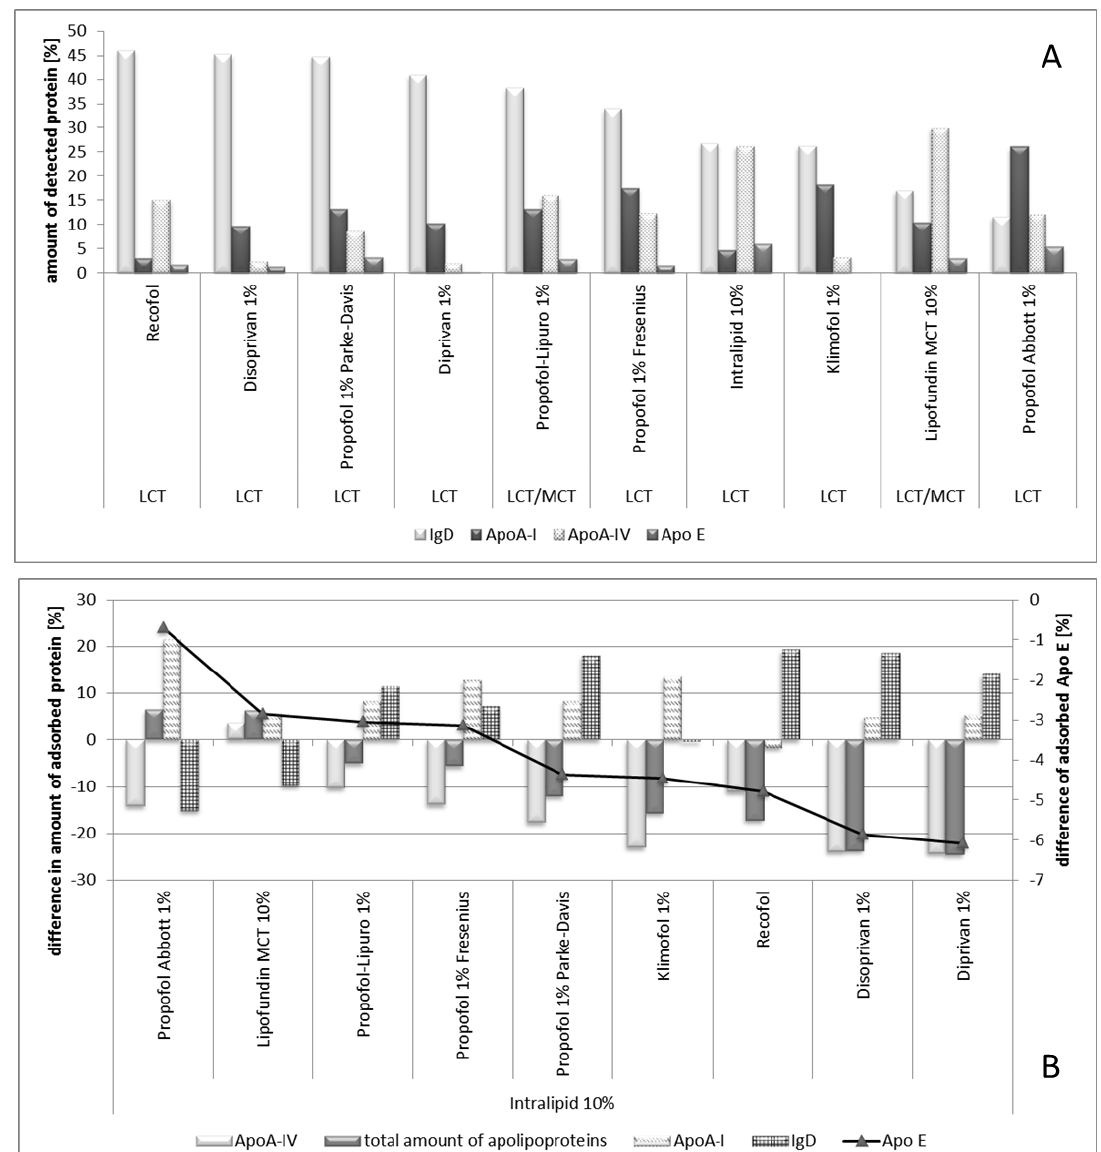
Figure 7. ( A ) Comparison of major proteins detected on the different propofol emulsions and the reference emulsions from which the propofol emulsions were derived. Protein amounts are given as a percentage of the total amount of protein detected on the 2-DE gels; ( B ) shown as differences in the amounts of adsorbed proteins in comparison to the original IV emulsion (Modified after